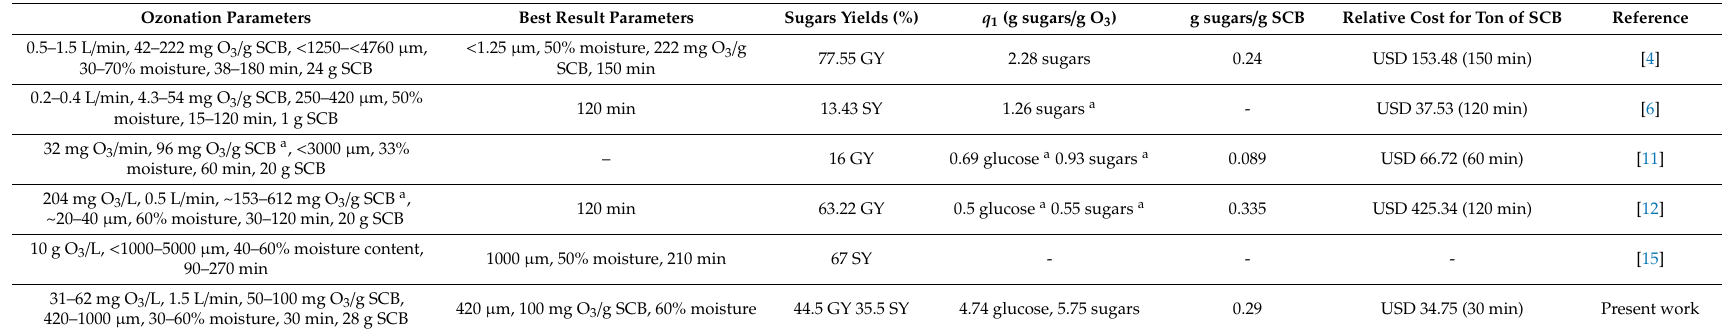
Table 3. Comparison of ozonation and enzymatic hydrolysis parameters on reported sugarcane bagasse ozone